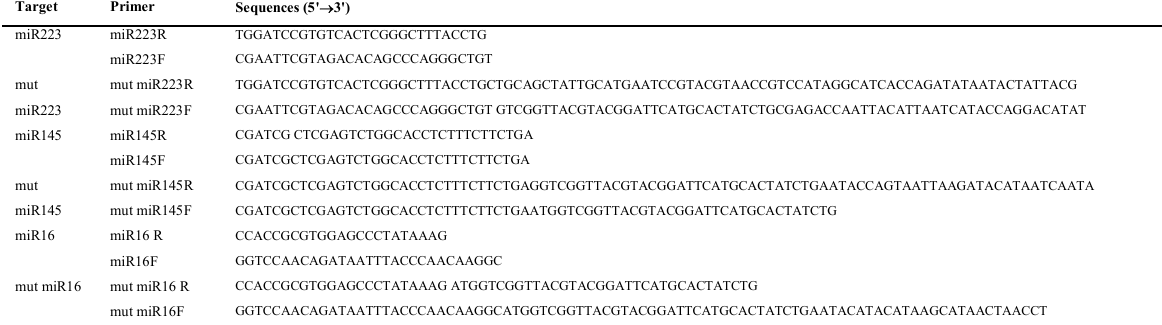
Table 1. The primer